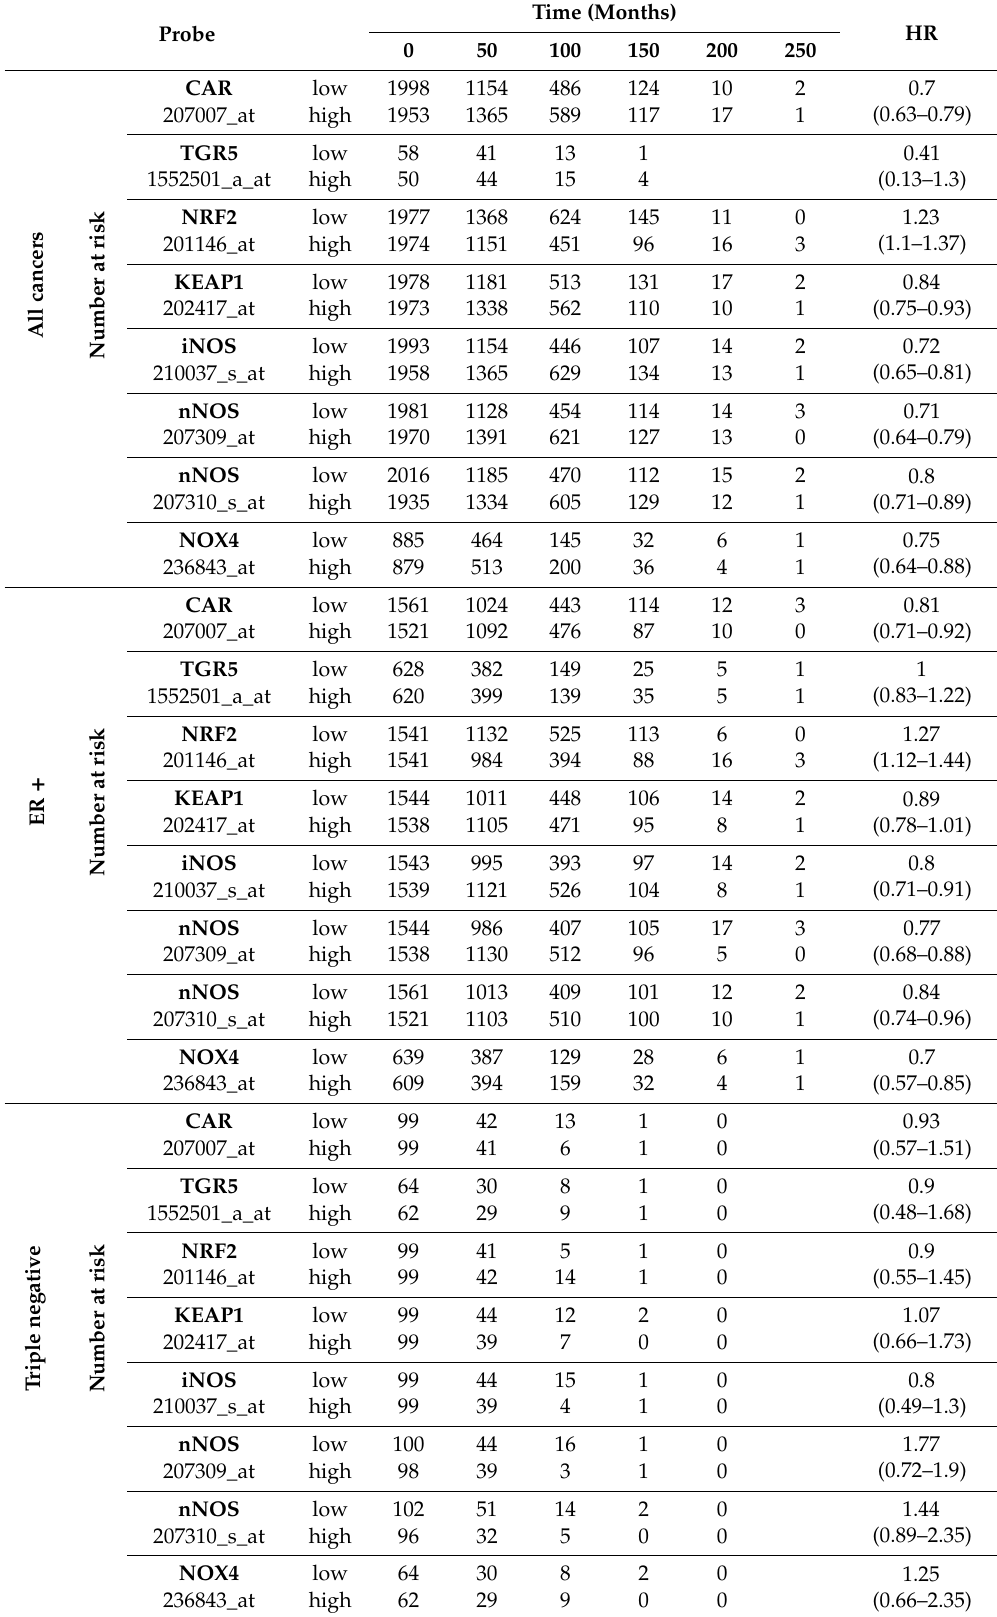
Table 5. Numerical values for kmplot analysis in Figure